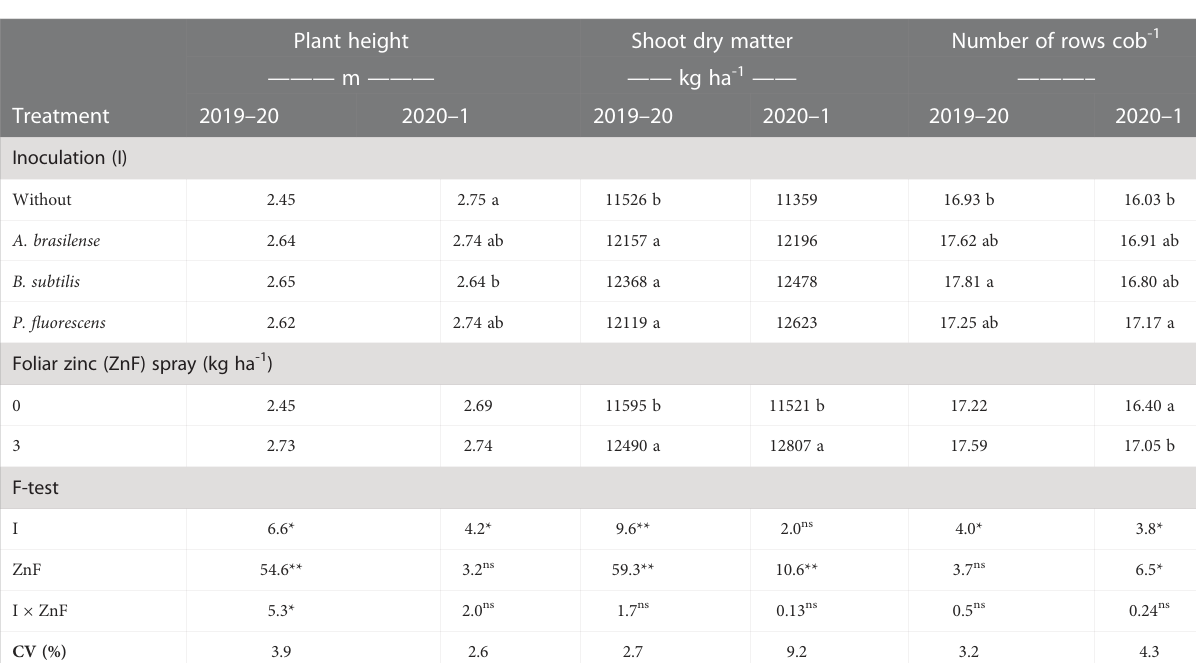
TABLE 2 Plant height, shoot dry matter, and number of rows per cob of maize as a function of plant growth-promoting bacteria inoculation, together with or without nano-zinc oxide spray in the 2019 – 20 and 2020 – 1 cropping seasons. Plant